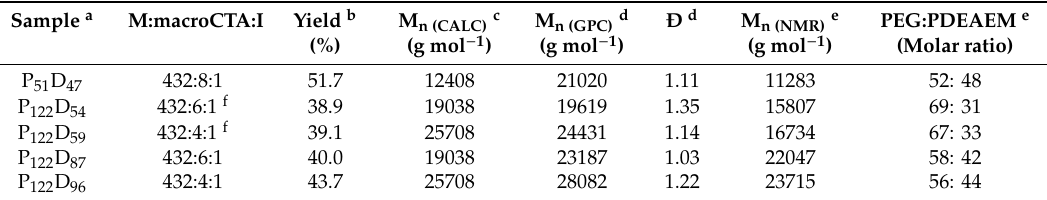
Table 1. RAFT polymerization of DEAEM in p-dioxane at 70 ◦ C for 48 h using PEG 51 - and PEG 122 -macroCTAs as RAFT agents. 288